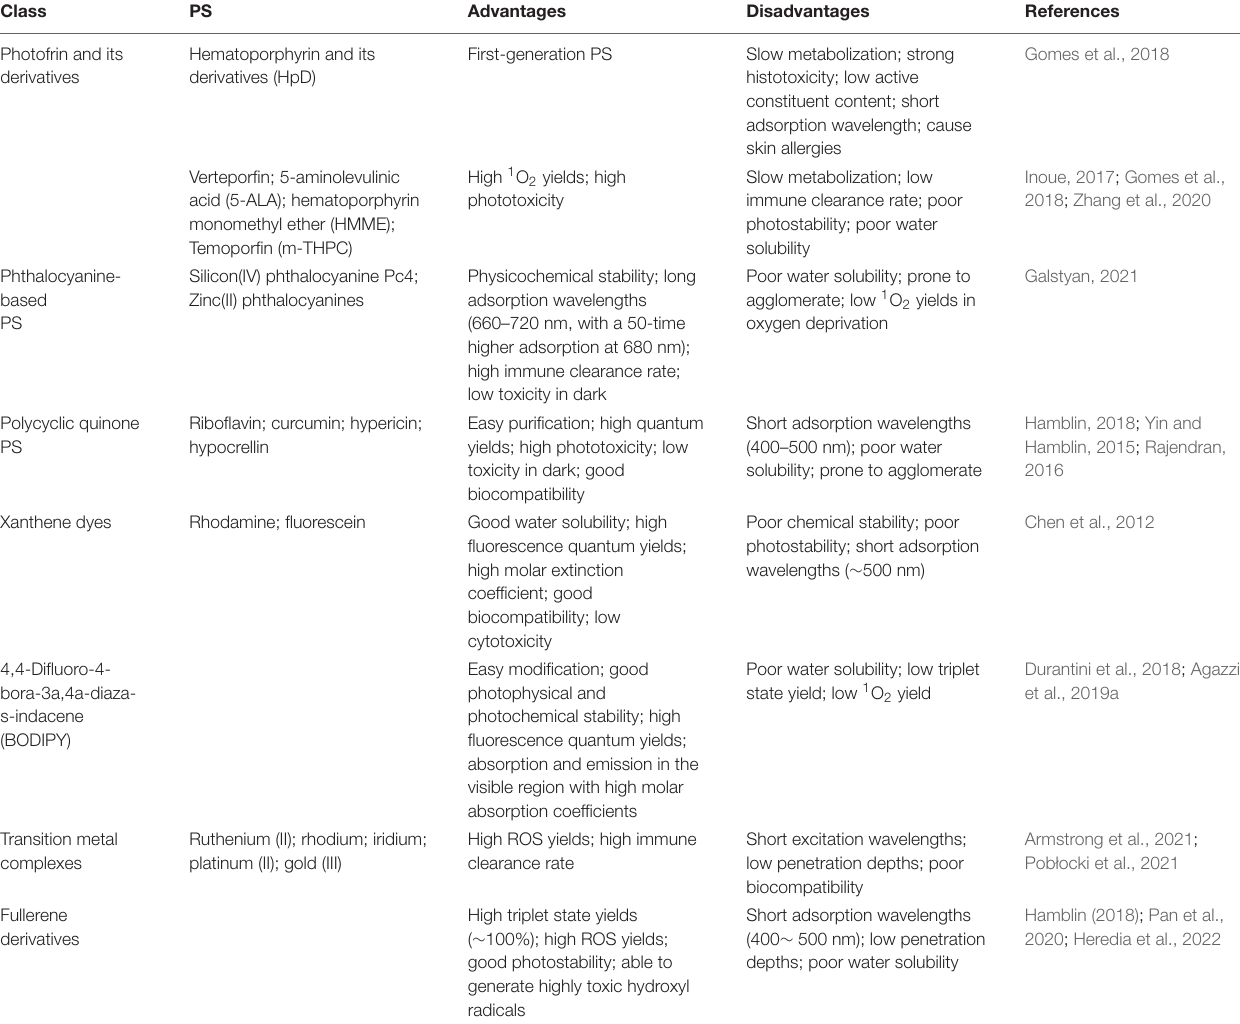
TABLE 1 | Advantages and disadvantages of commonly used